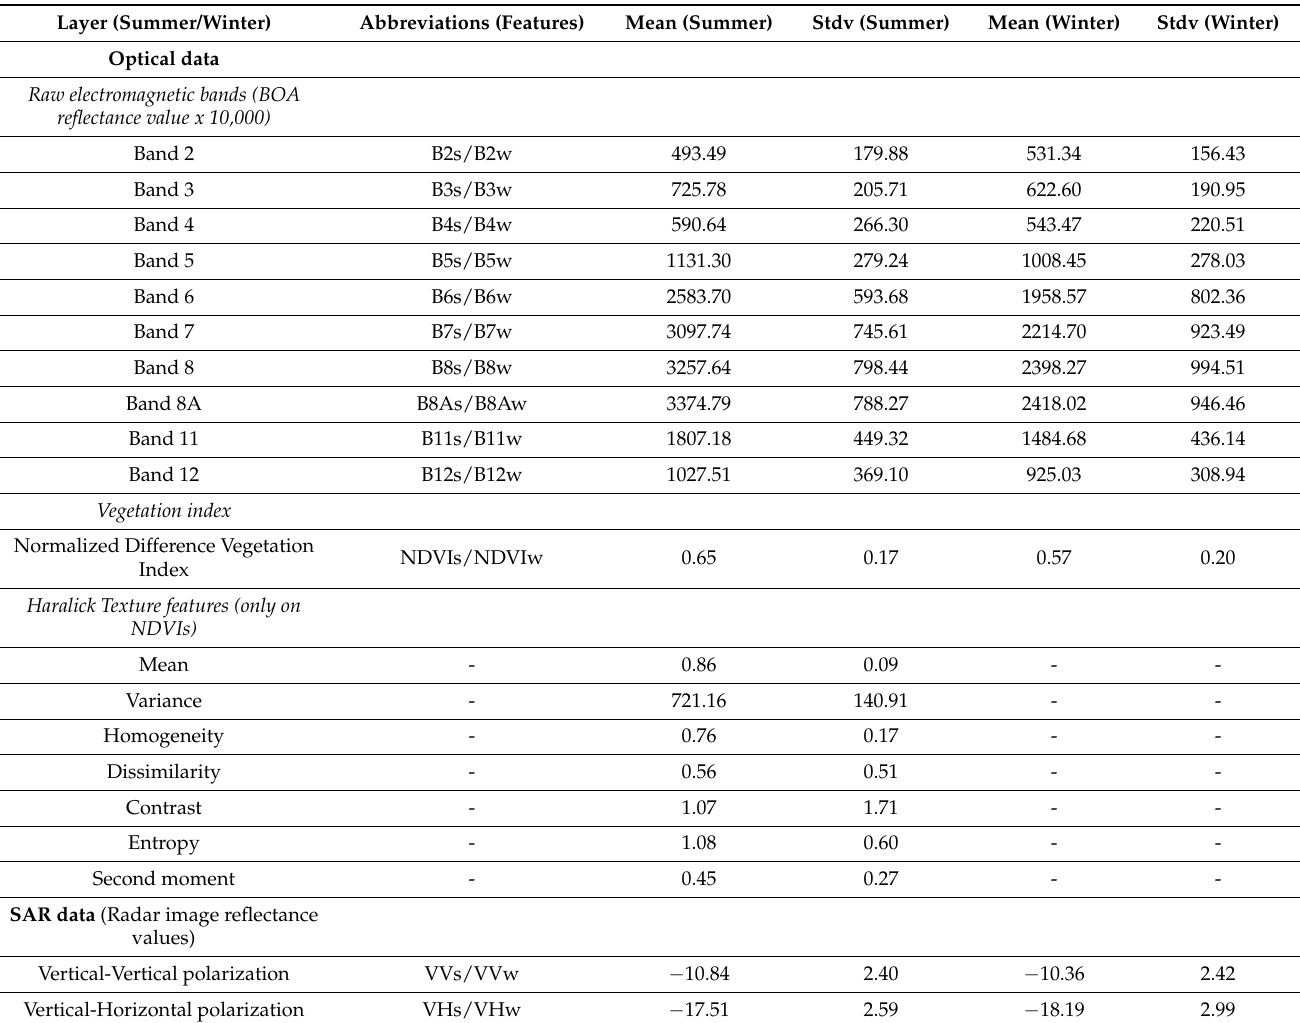
Table A1. Feature layers included in the models and their mean and standard deviation. All features except the texture features comes in a summer (s) and a winter (w)